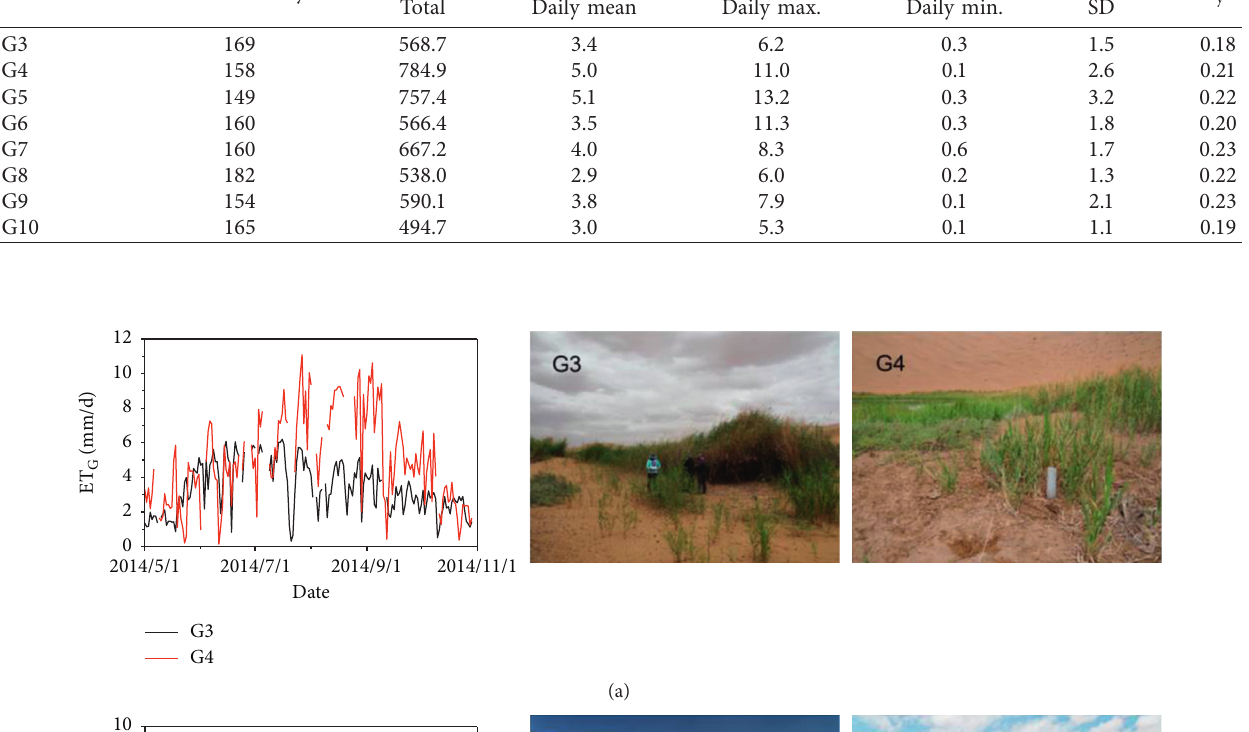
Table 2: Statistics of the estimated groundwater evapotranspiration (ET days used in the estimation, and the specific yield ( S y ). Well no.